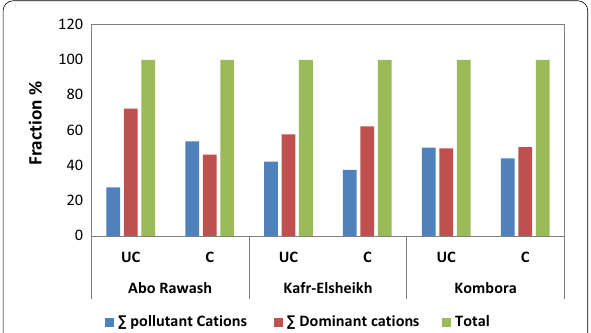
Fig. 2 Relationship between % forms of sum of all exchangeable cations, sum of exchangeable dominate cations (EDC) and sum of exchangeable pollutant cations (EPC) in different studied